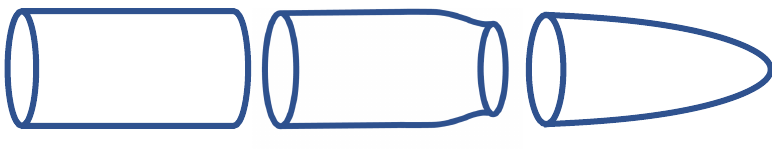
Figure 1 . Shown from left to right are the compact time-radial parts of the geometries of our thermal equilibrium solutions, of the HP solution and of the cigar background. The three-form flux stabilizes the radius of the thermal circle, counteracting gravity. Without flux, an approximate thermal equilibrium is described by the HP solution. The cigar background deviates significantly from thermal equilibrium: the thermal circle is contractible and vanishes at the